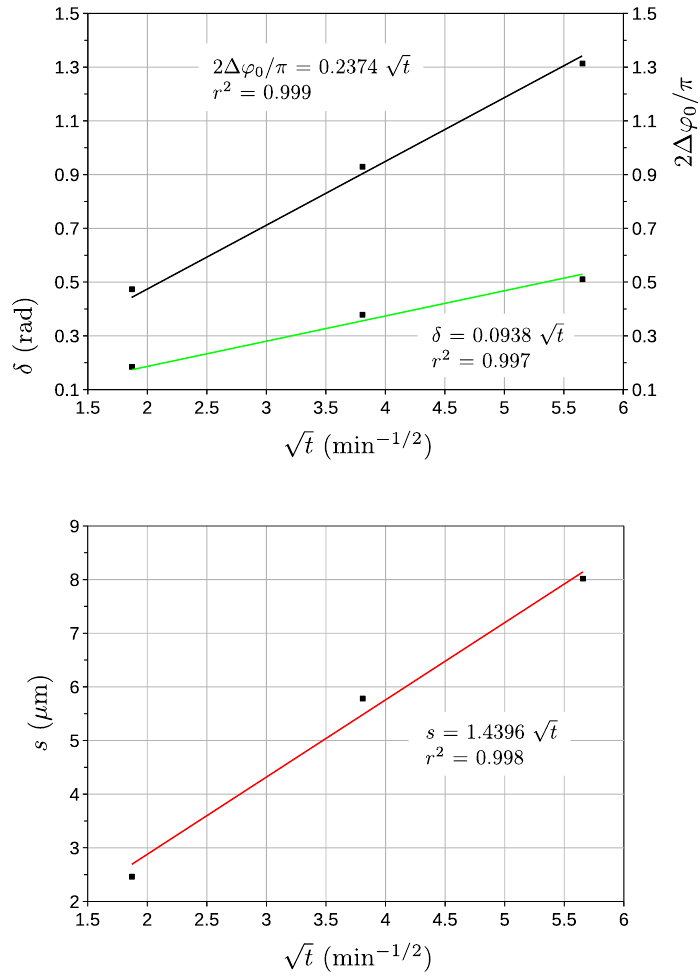
Figure 4. Data points of the polygonal model that best predicted the experimental efficiencies of the three gratings fabricated to characterize the ion-exchange process; the lines of the best fit as functions of the square root of the ion-exchange time are also plotted. The parameter w was fixed to 9.1 µ